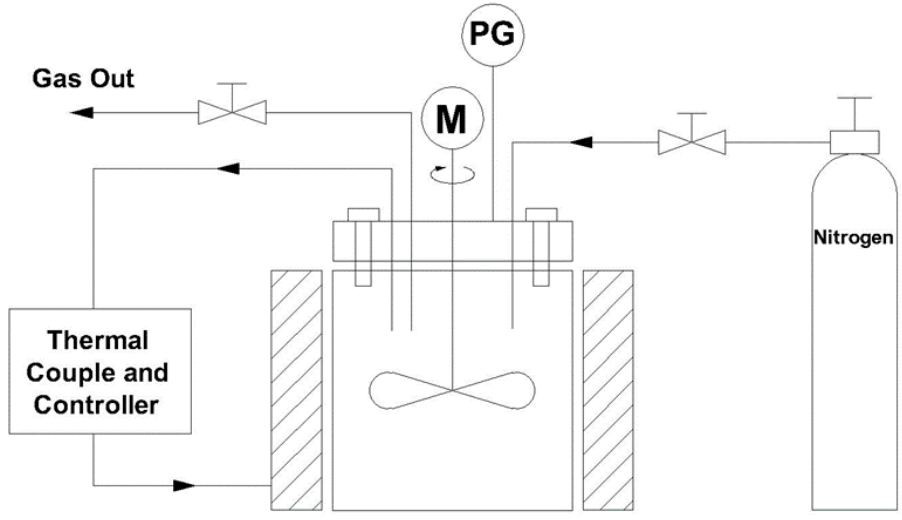
Figure 1. Schematic diagram of the batch reactor.